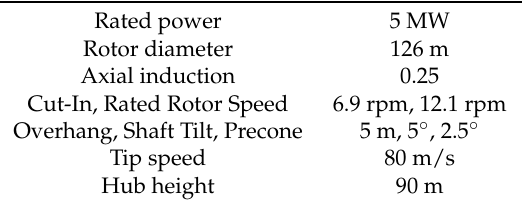
Table 3. Basic characteristics of the NREL 5 MW reference turbine